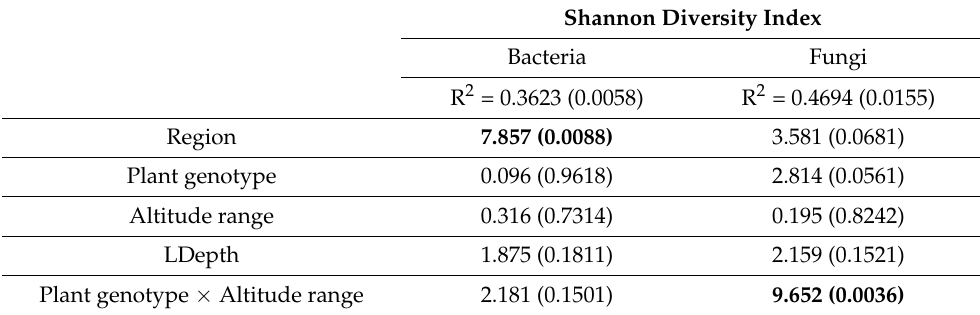
Table 1. Factors predicting alfa-diversity of rhizosphere bacterial and fungal